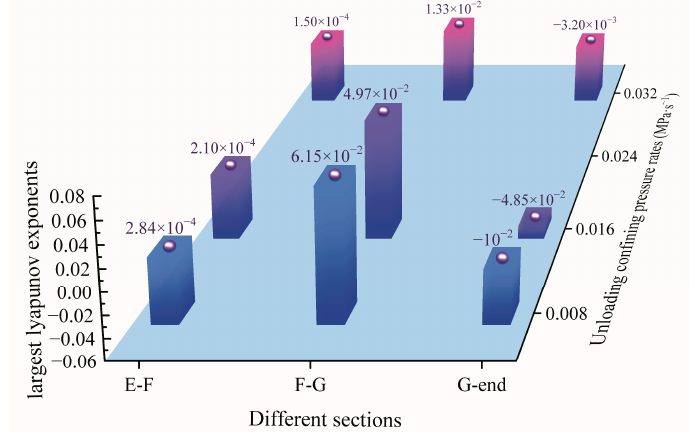
Figure 9. Maximum Lyapunov exponents in different damaged sections of diorite under variable unloading confining-pressure rates.